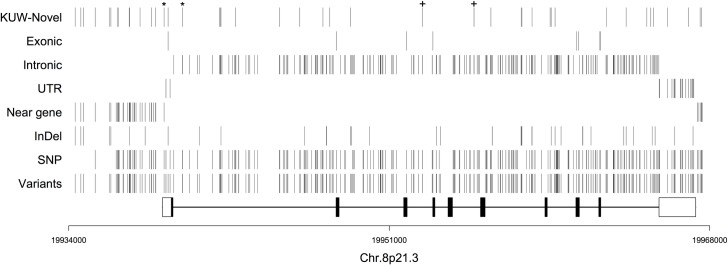
Distribution of the total variants (n = 291) including the 47 novels identified at the LPL gene locus among the 100 Kuwaiti Arab samples.The variants are shown based on their location across the 30Kb gene. The shaded boxes represent exons 1–9 and the open box represents the untranslated regions (UTR). The positions of the variants are based on gene build 89 and genome assembly GRCh38 [26]. The (+) indicate the novel variants KUA LPL-27 and KUA LPL-28. The stars indicate the variants (KUA LPL-15 and KUA LPL-17) selected for validation yet failed synthesis by real-time PCR.